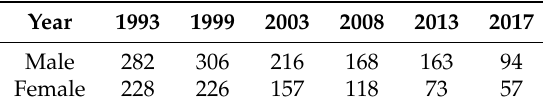
Table 4. Gender Ratio of